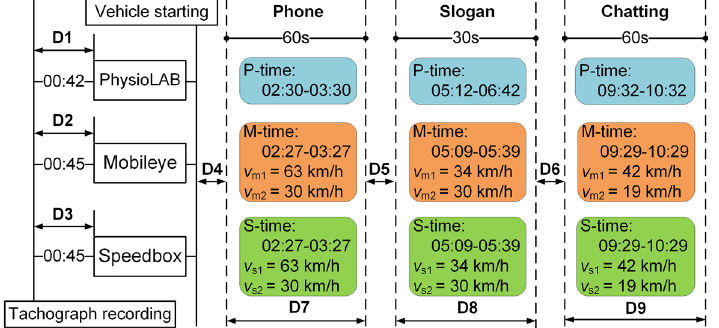
Figure 3. Extraction of available